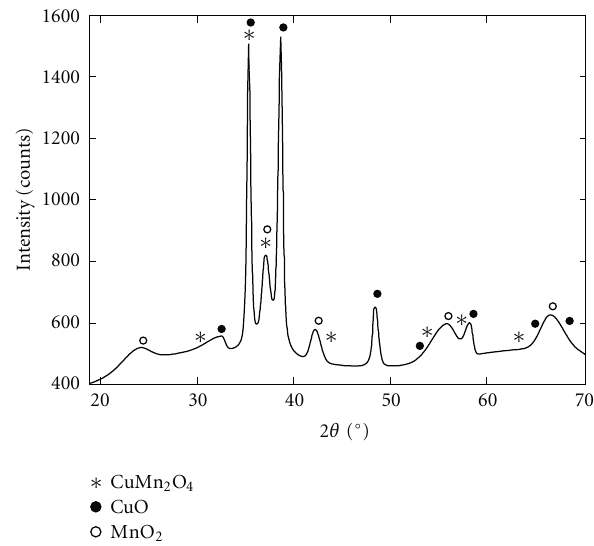
F 2: Powder X-ray diffraction pattern of mixed CuMn Each symbol indicates peak of the corresponding phases.